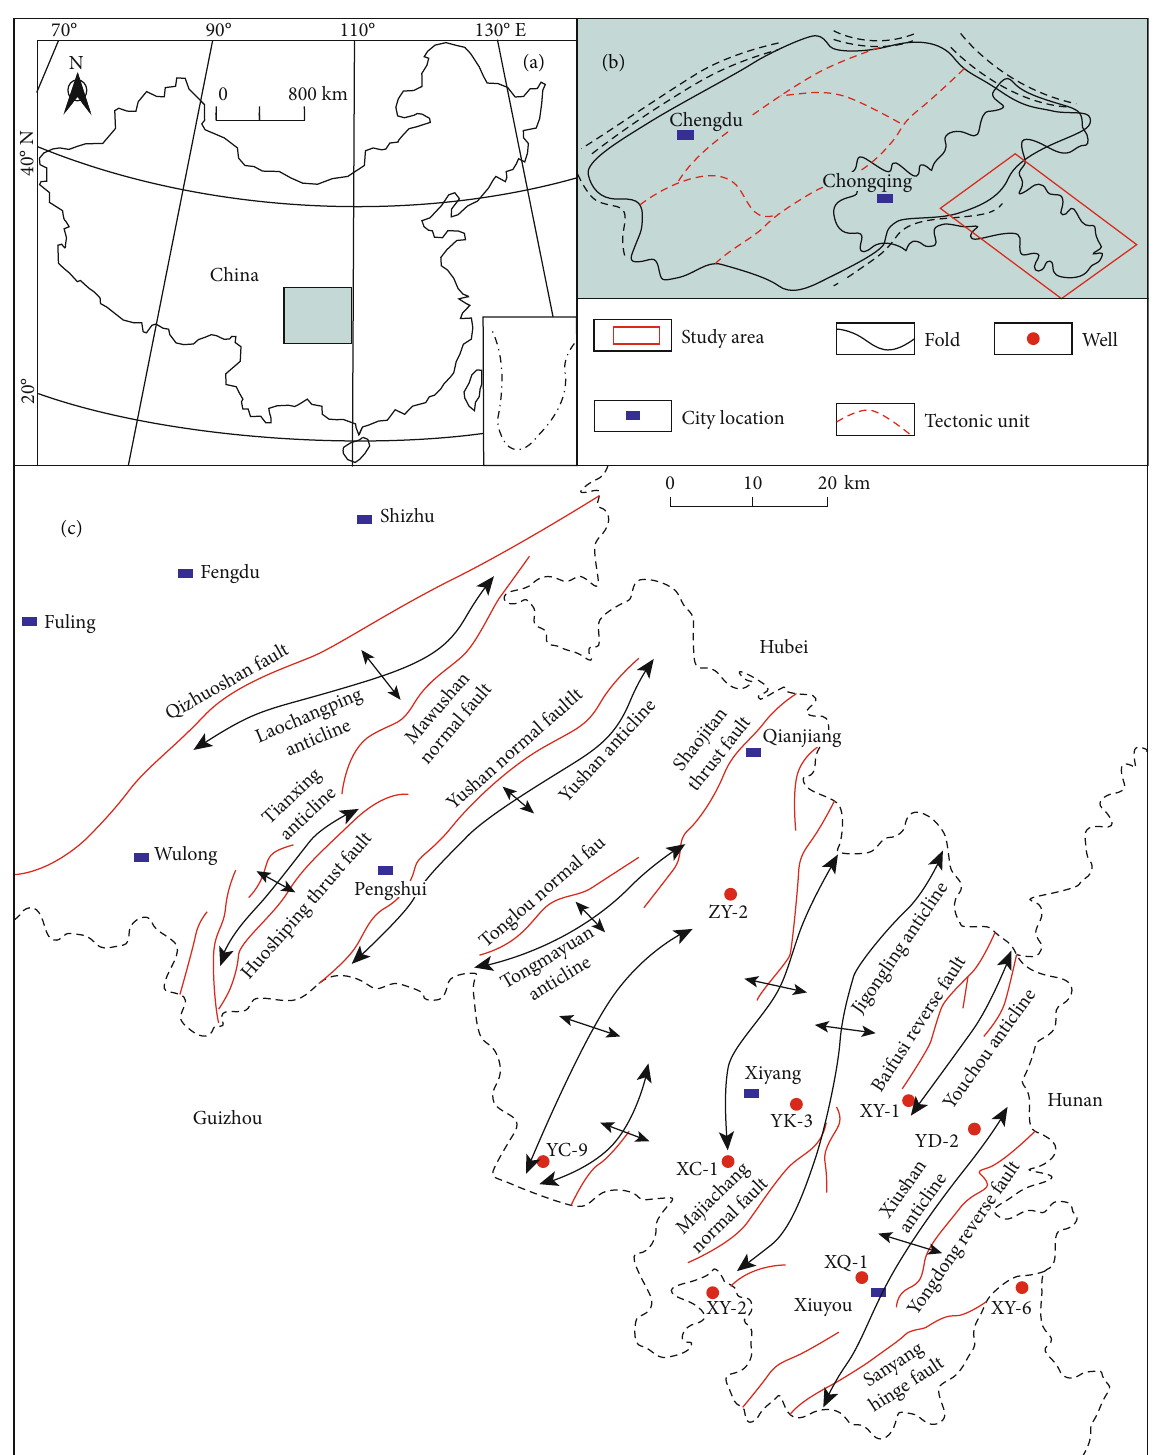
Figure 1: Distribution map of folds and fault systems in the target layer of southeastern